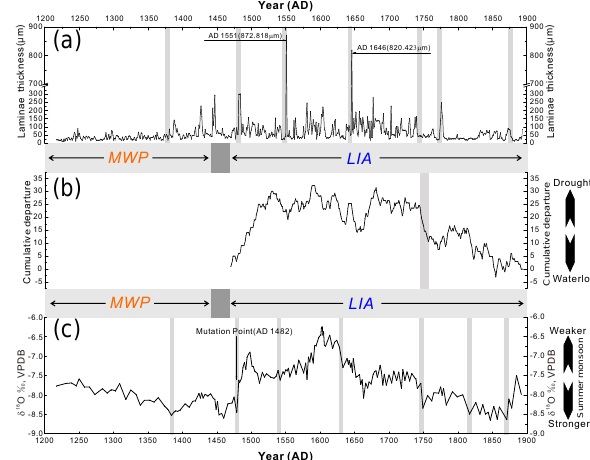
Figure 7. The year of formation and the thickness data series of the 678 laminae in the upper part (0–42.769mm) of stalagmite ky1 (a) , the cumulative departure curve (b) and the δ 18 O ratio data series for 172 samples (c) . The thicknesses of the laminae formed in AD1551 and 1646 were up to 872.818 and 820.423µm, respectively, much higher than other laminae. The cumulative departure curve (b) is drawn by drought–waterlog indices on the basis of the Yearly Charts of Dryness/Wetness in China for the Last 500-Year Period (Chinese Academy of Meteorological Sciences of the China Meteorological Administration, 1981). The curve has a rising trend representing less precipitation and the climate becoming drier, and the curve has a declining trend representing more precipitation and the climate becoming